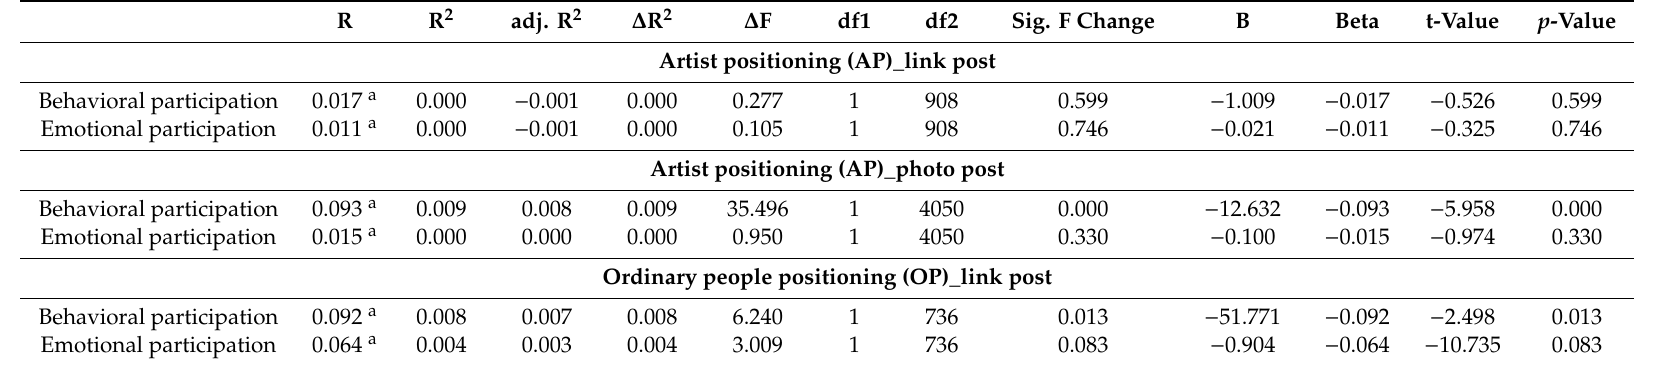
Table A4. Linear regression coe ffi cient of determination and beta (link post and photo